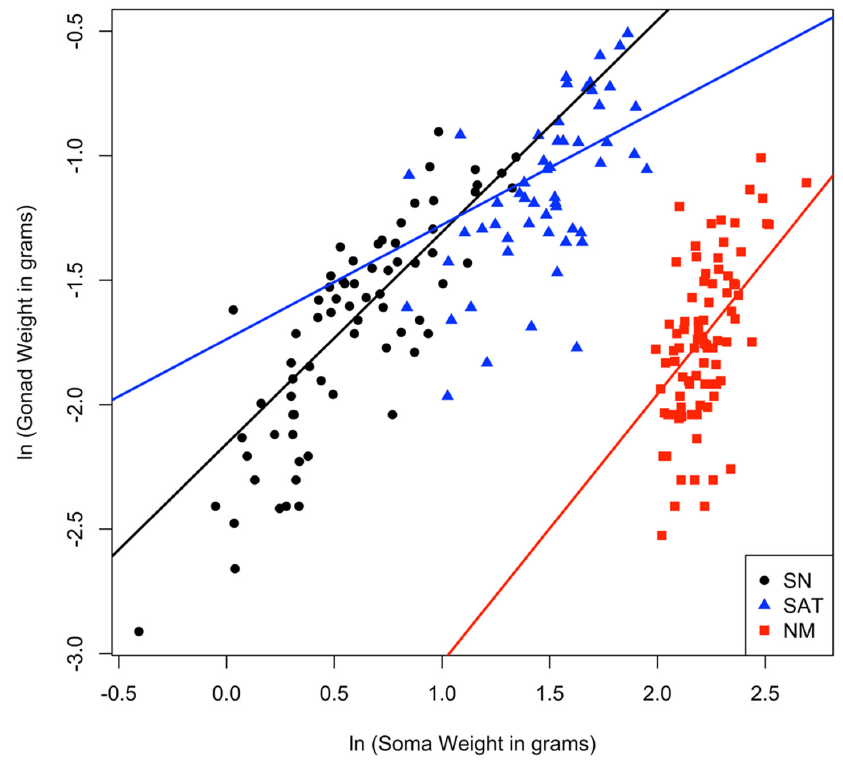
Figure 2. The allometric relationship between soma weight and testes weight differs significantly among alternative male types, based on the mixed effects model reported in Table 1 which fit ln(gonad weight)=intercept + slope ln(soma weight). In this relationship, all three types have significantly